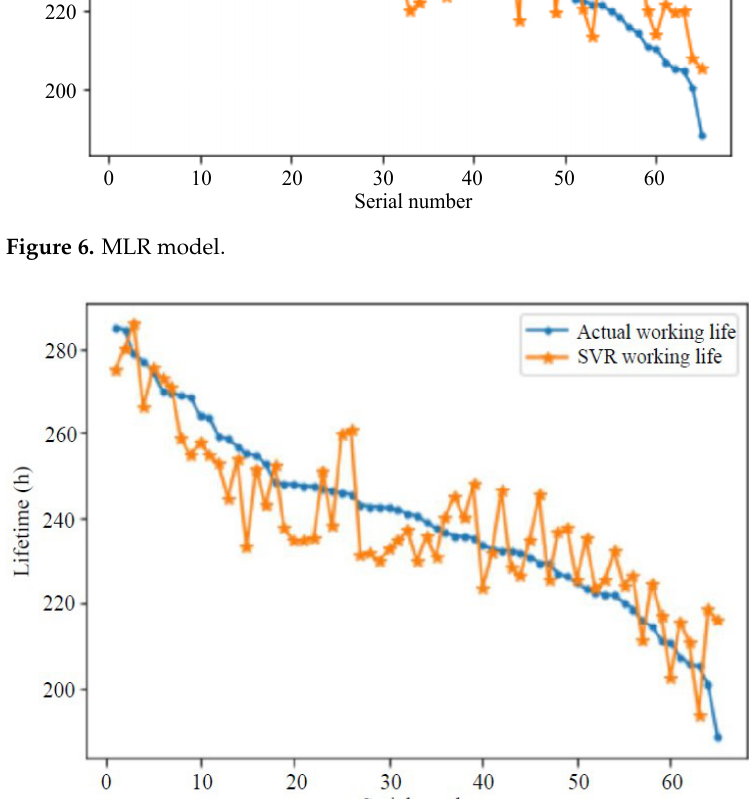
Figure 7. SVR model.